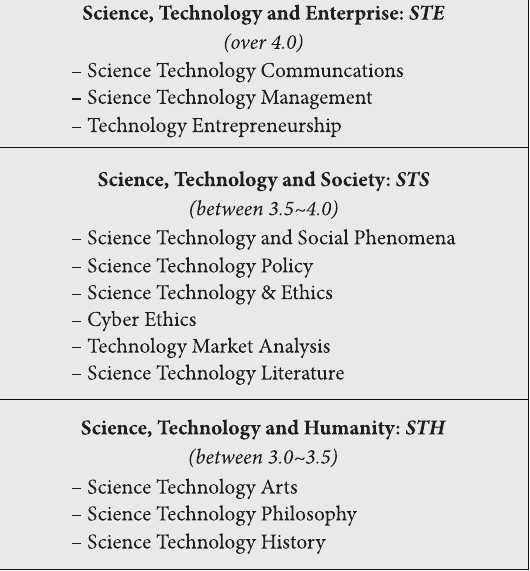
Fig. 2. Grouping of cross-disciplinary